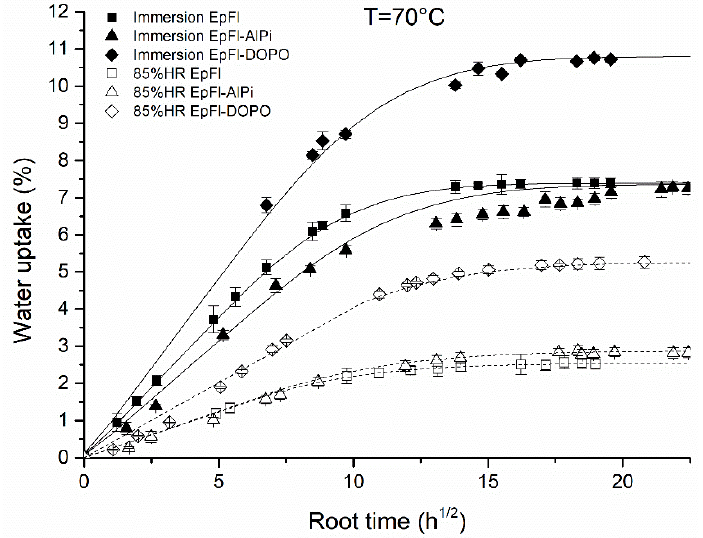
◦ C in liquid water and water